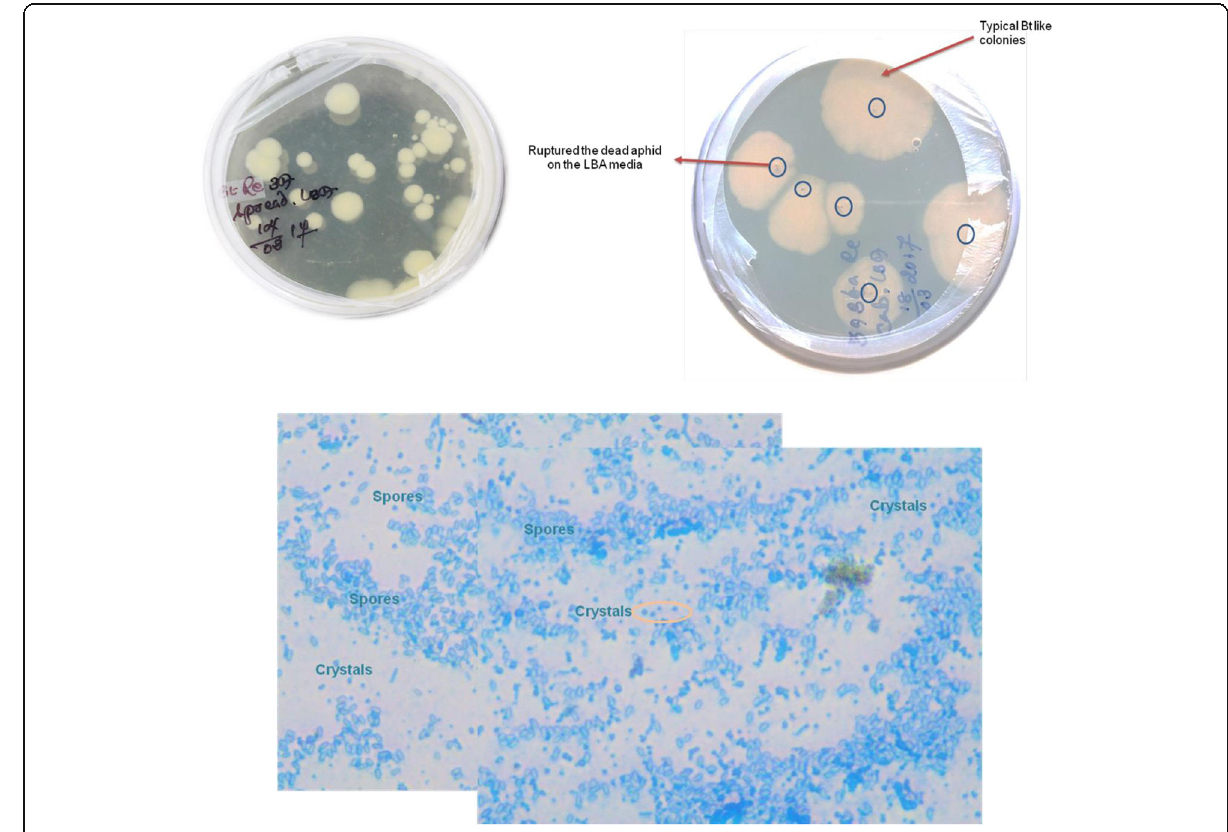
Fig. 8 Aphidicidal Bt strains were re-isolated from the dead aphids to fulfil Koch ’ s postulate. A typical white and opaque and round colony morphology was prominent. Crystal staining of Bt re-isolated from dead A. gossypii and A.